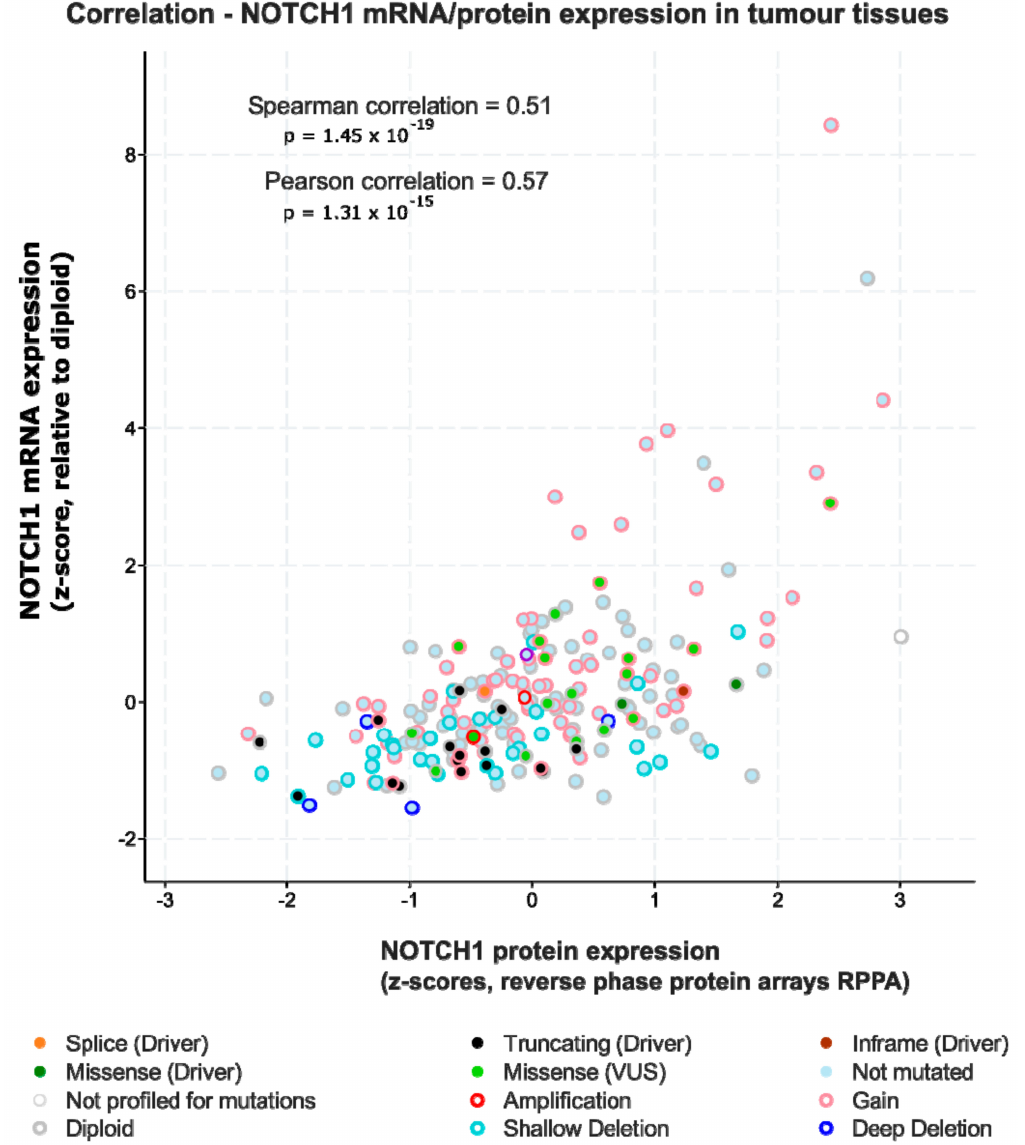
Figure 2. Correlation of mRNA and protein expression of NOTCH1 in HNSCC illustrates the likely bimodal functional activities of this gene, which can act as both tumour suppressor and proto-oncogene. The graph shows the levels of NOTCH1 mRNA (RNA seq, counts per million reads), plotted against NOTCH1 protein (reverse-phase protein arrays, RPPA; from TGCA “Firehose Legacy” data set). Tumours with NOTCH1 deletion (light and dark blue circles) and/or truncating, loss-of-function mutations (black dots) typically express low to very low ratios of both NOTCH1 mRNA and protein. In contrast, a fraction of tumours (marked by light red circles) show marked over-expression of NOTCH1 mRNA and protein. Missense mutations are rare in these tumours, and no truncating mutations were